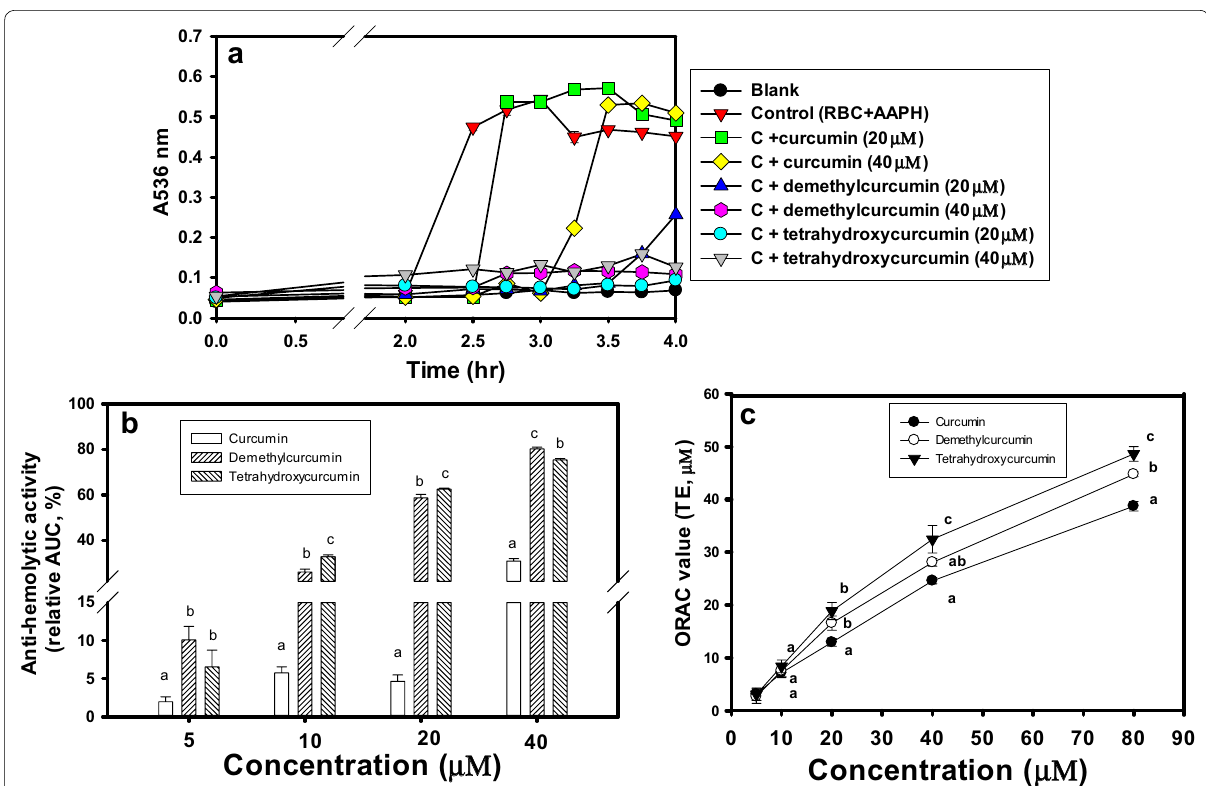
Fig. 2 Anti‑hemolytic and ORAC activities of curcumin, demethylcurcumin, and tetrahydroxycurcumin in vitro. a The typical profiles of three curcuminoids (20 and 40 μM) on protections against AAPH‑mediated hemolysis during 4 h (expressed as A536 nm). b The quantification of anti‑hemolysis (%) of three curcuminoids (5, 10, 20, and 40 μM) by calculating relative AUC. c The ORAC activities of three curcuminoids and expressed as Trolox equivalents (μM TE). Values were presented as mean SD and were analyzed using one‑way ANOVA, followed by a post hoc ± Tukey’s test for multiple comparisons of anti‑hemolytic activities. The P < 0.05 was considered statistically significant and marked with different letters among treatments under the same